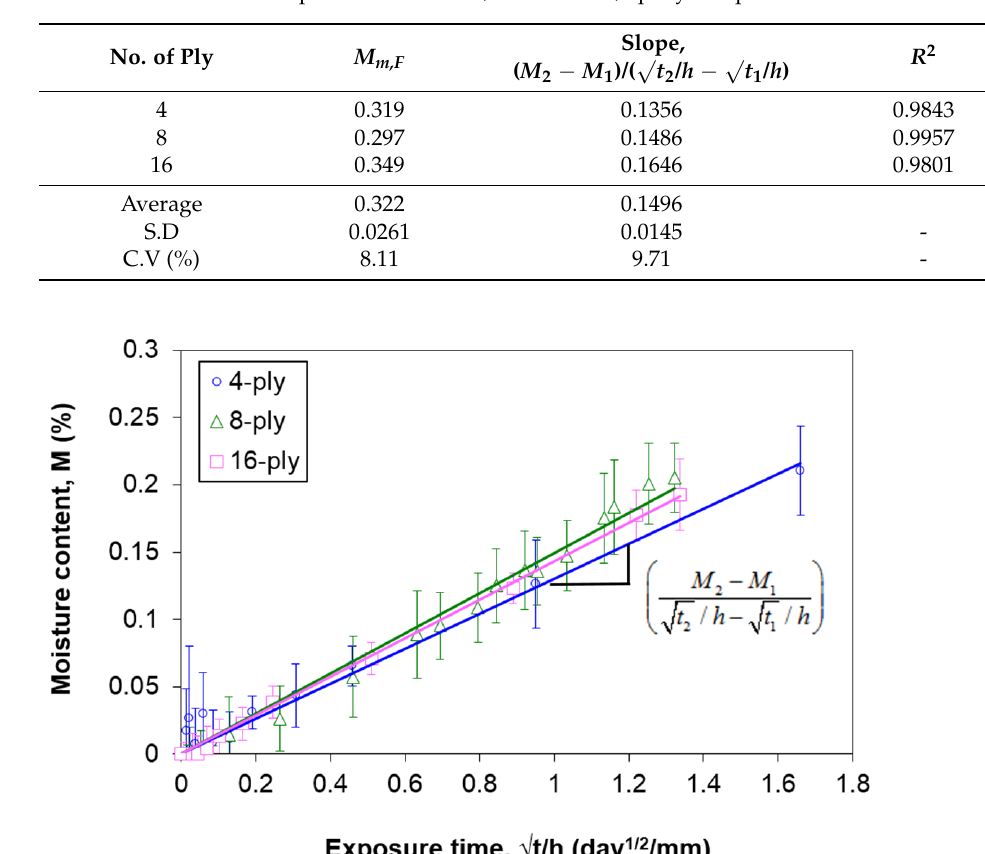
Table 1. Fictitious Fickian parameters of AS4/8552 carbon/epoxy composites.